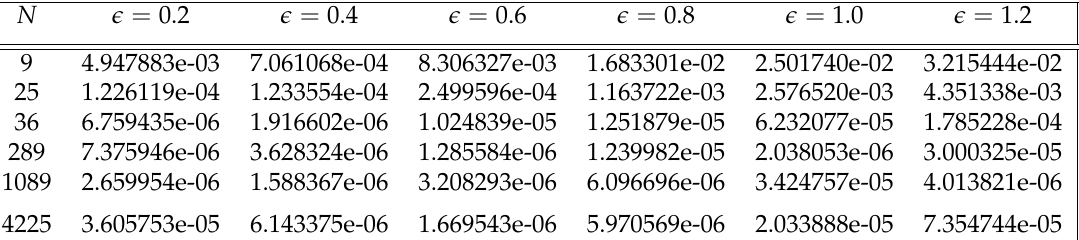
Table 2. RMSE for Example 1 over a range of shape